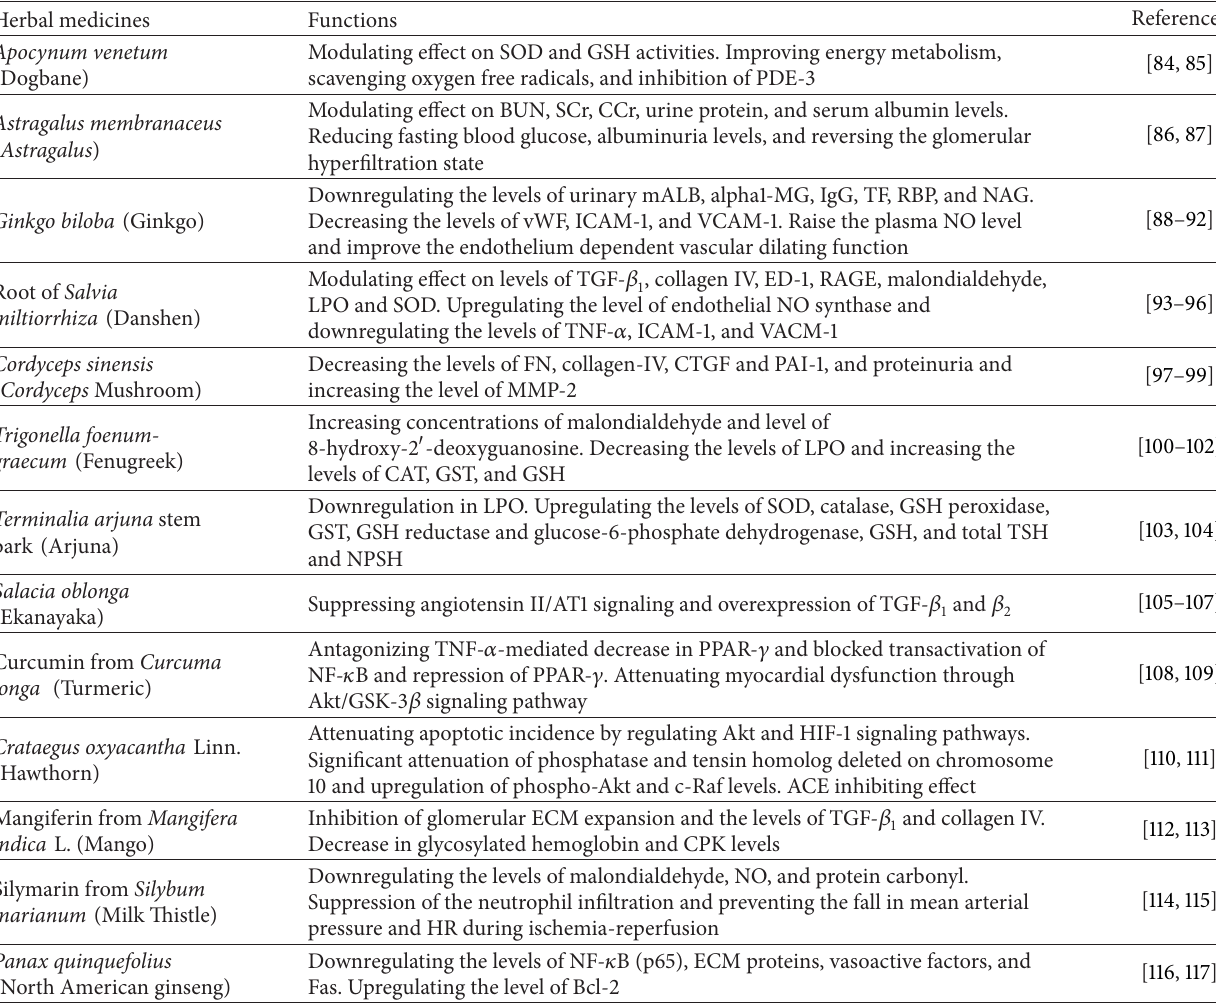
Table 1: Modern research on natural medicines capable of modulating cardiorenal syndrome related